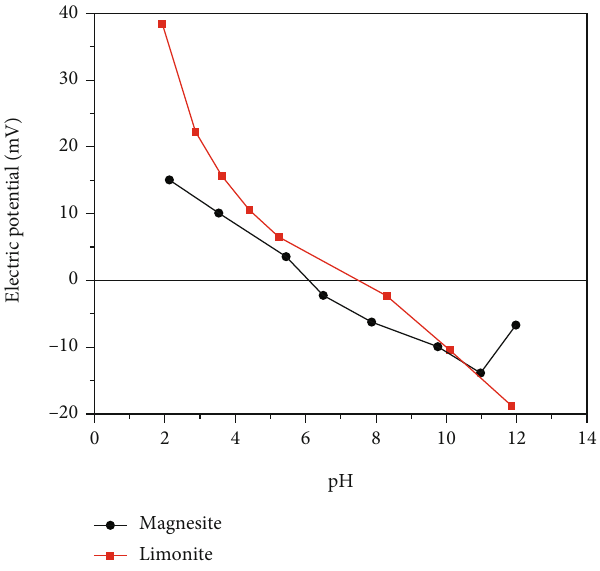
Figure 7: Magnesite and limonite zeta potential.